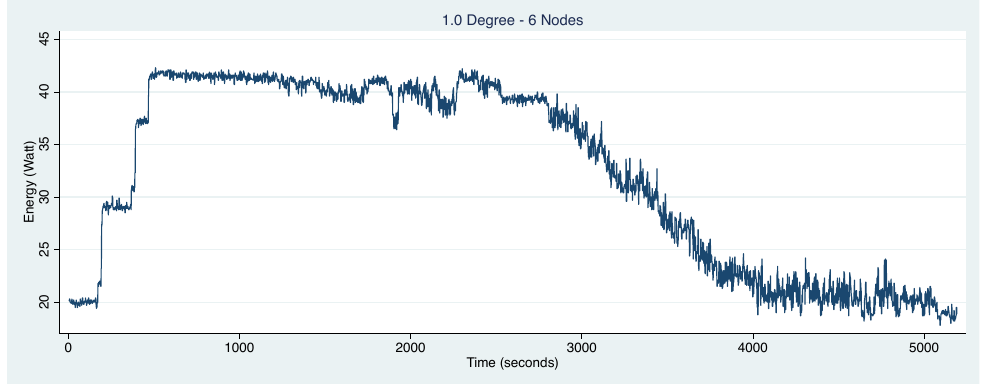
Figure 8. Energy consumption of a Montage 1.0 degree workflow on a 6 node